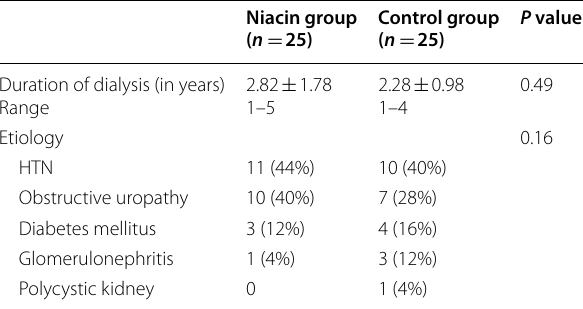
Table 2 Etiology of kidney disease and duration of dialysis among studied groups